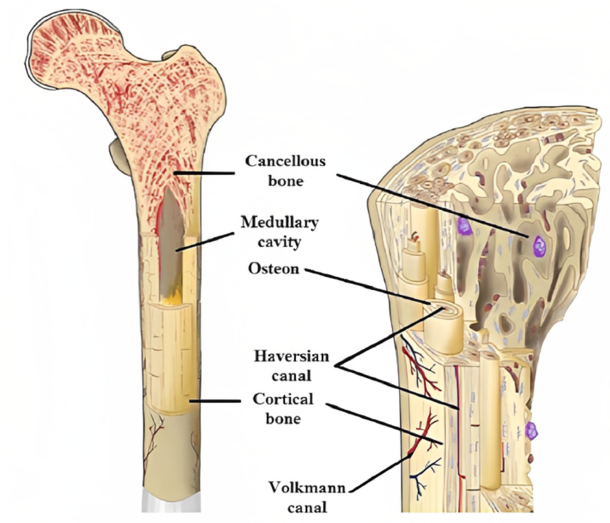
Figure 2. Indicative image of a human bone structure [52].